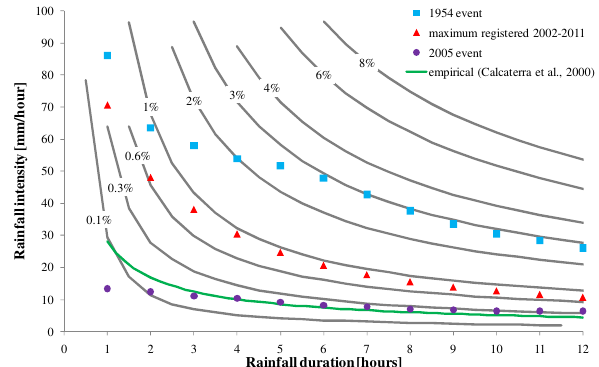
Fig. 8. Comparison between registered rainfalls and simulated ID Figure 8. Comparison between registered rainfalls and simulated ID curves at fixed values of 2 curves at fixed values of the failure percentage. the failure percentage. 3